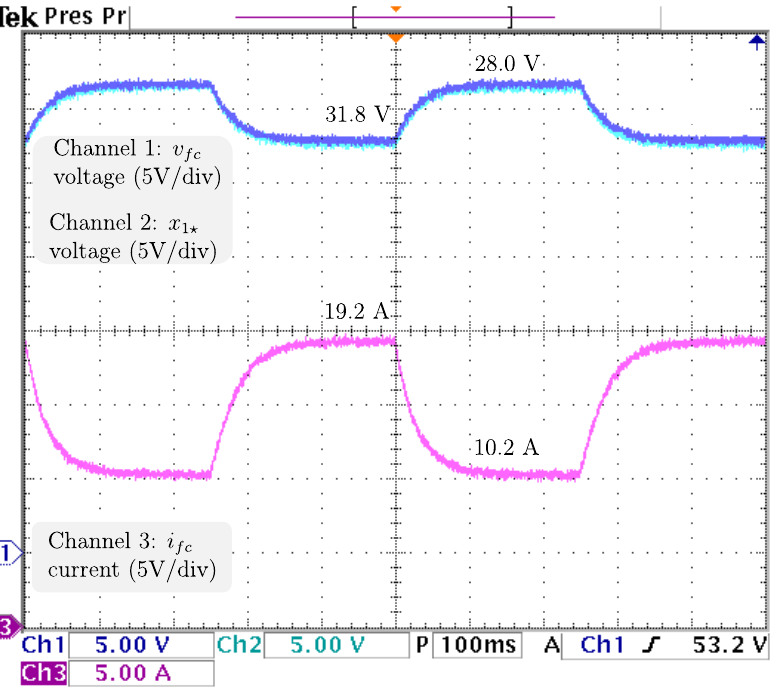
Figure 11. Real-time results for sudden output voltage changes. From top to bottom: v fc , the fuel cell voltage; x 1 (cid:63) , the fuel cell voltage reference; and i fc , the fuel cell